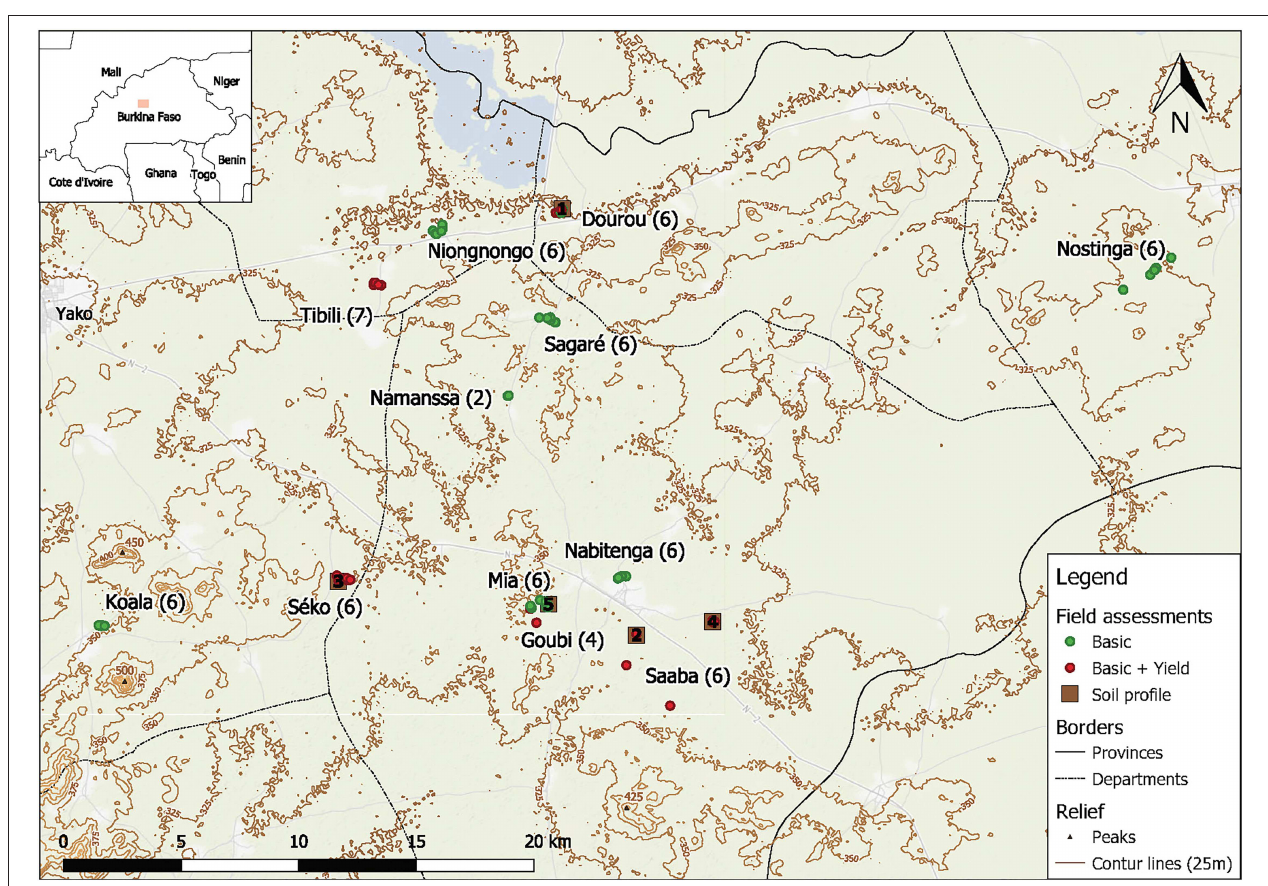
FIGURE 1 | The map of the study area depicts the location of the 67 yam fields and the 5 soil profiles. The villages and the numbers of participants per village are noted on the